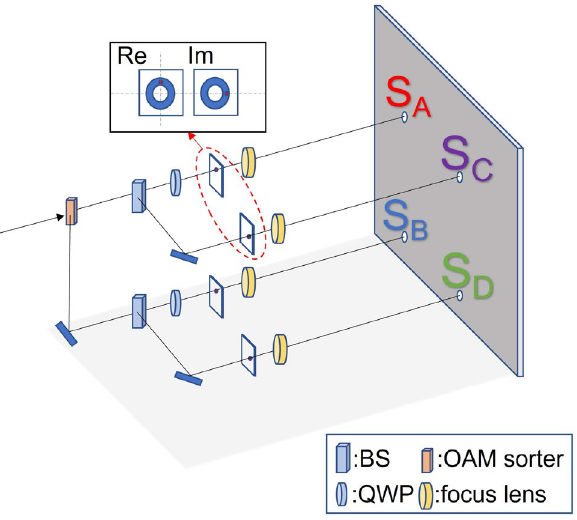
Figure 5. Optical path diagram of the detection method. The DFT output beam first goes through a OAM sorter to separate the beam into different LG modes. Then two beams are decomposed into four beams by two BSs. By the orthogonal aperture diaphragms, the LG beams are separated into the real and imaginary components. Finally, refocused beams enter the four holes as the interference sources. The elements in the upper box represent the orthogonal aperture diaphragms, BS is beam splitter, QWP is quarter-wave plate.